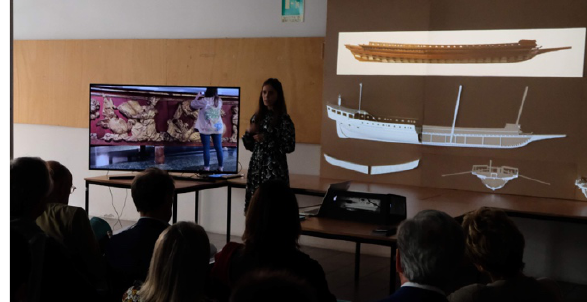
Figure 13. Presentation of the exhibit done by Agnese